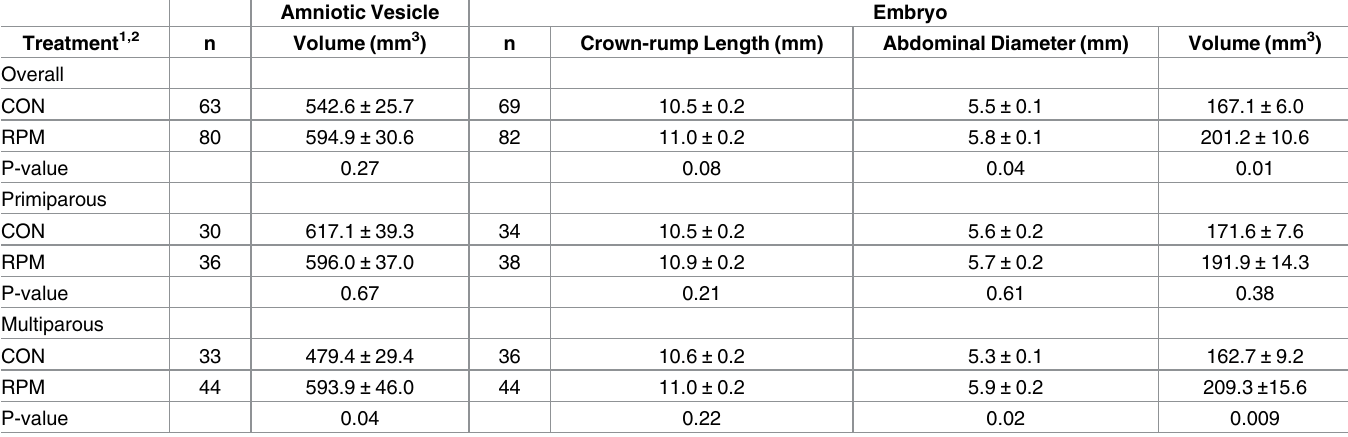
Table 7. Effect of rumen-protected methionine (RPM) feeding on ultrasonographic morphometry of amniotic vesicle and embryo on gestation Day 33. Amniotic